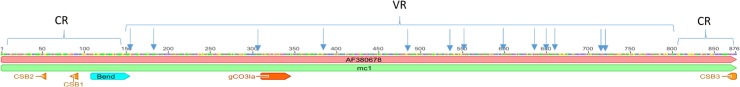
Location of conserved single nucleotide changes in representative minicircle.Diagram of linearized mc1 minicircle showing the relative locations of similar conserved patterns of single nucleotide changes (arrows) as in Fig 5. CR indicates Conserved Region, VR indicates Variable Region.